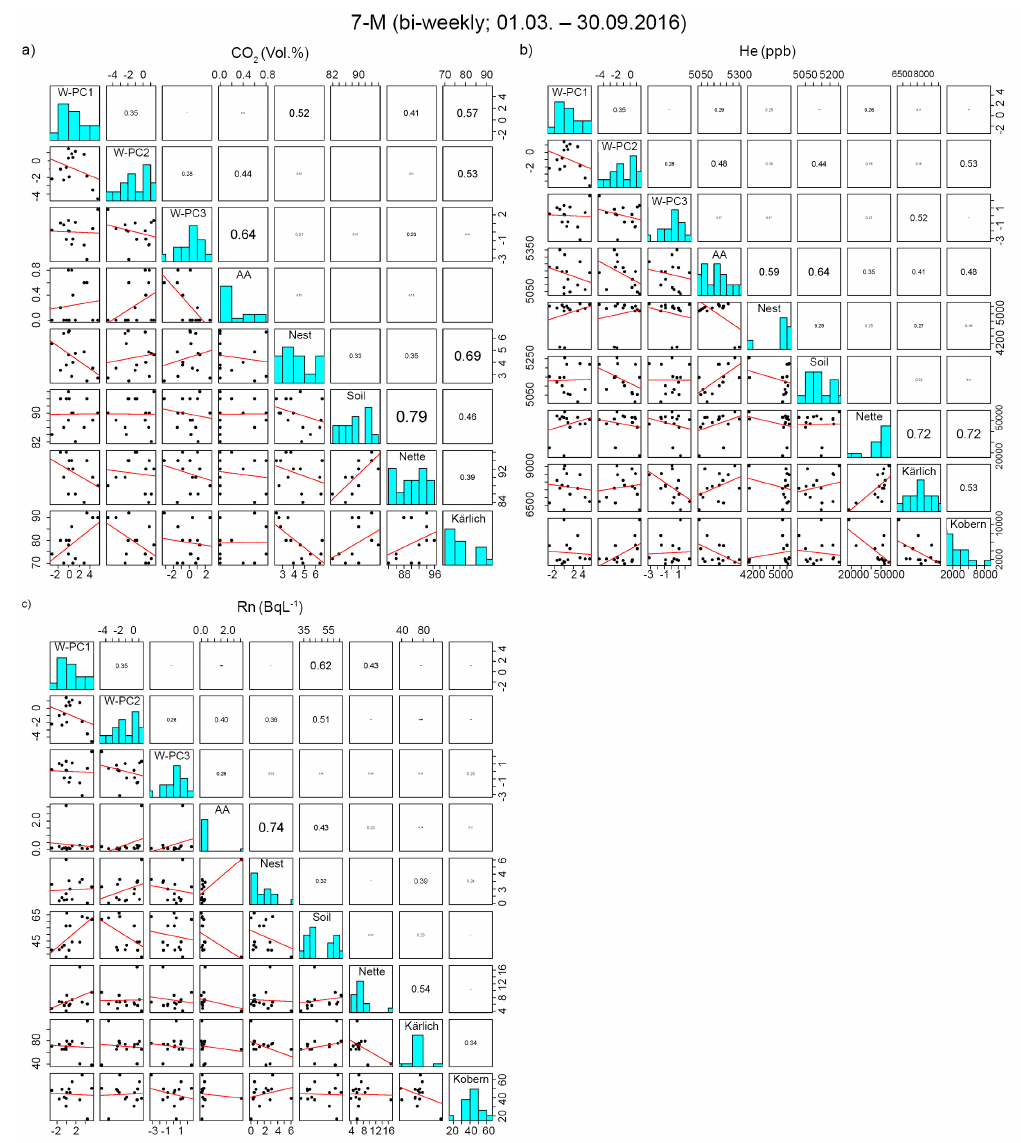
Figure A1. Correlation coefficients of the principal components analysis of weather variables with geogenic gas concentrations for ( a ) CO 2 , ( b ) He, and ( c ) Rn for AA, NG, SG, and the three mineral springs for the 7-M samples; W-PC1 =